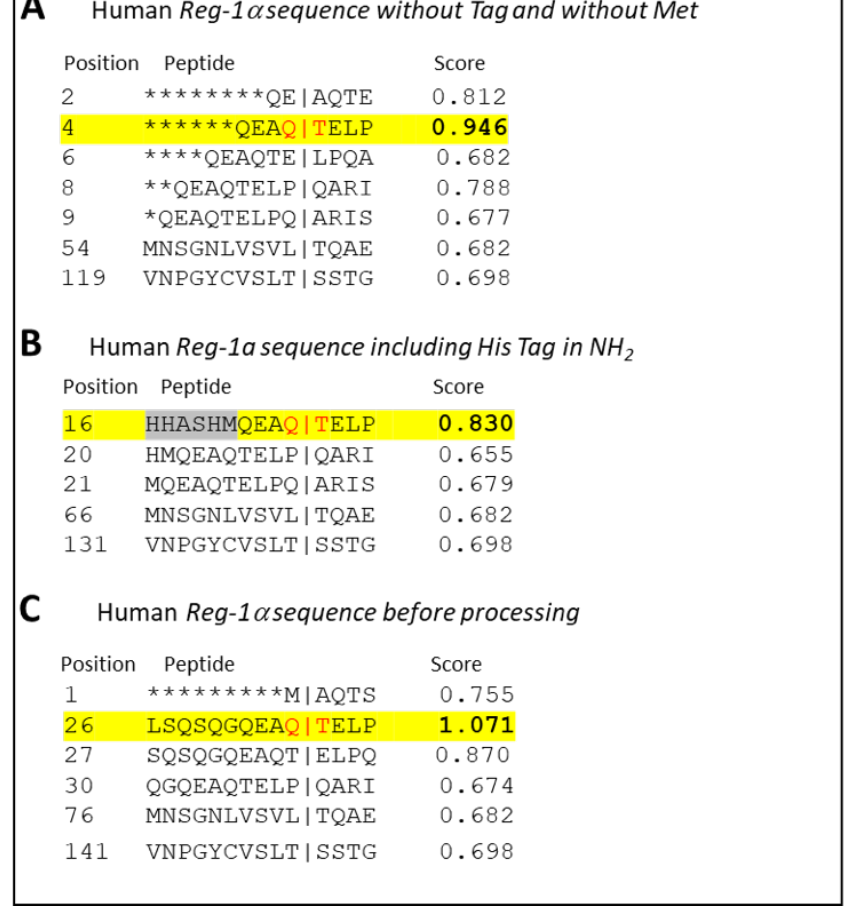
Figure 3. Prediction of the calpain-2 cleavage site of Reg-1 α using GPS-CCD (calpain cleavage detector). ( A , B ) Result obtained using the GPS-CCD software [32] with the sequence of the recombinant human Reg-1 α without ( A ) or with ( B ) the NH 2 -terminal His-tag and initial Met (natural protein/recombinant protein expressed in bacteria) and ( C ) with the human Reg-1 α sequence, including the signal peptide (before processing). The position of the calpain-2 cleavage site predicted with the higher score is highlighted in yellow and the exact position noted in red. Note that the results of the score were obtained with the higher threshold.